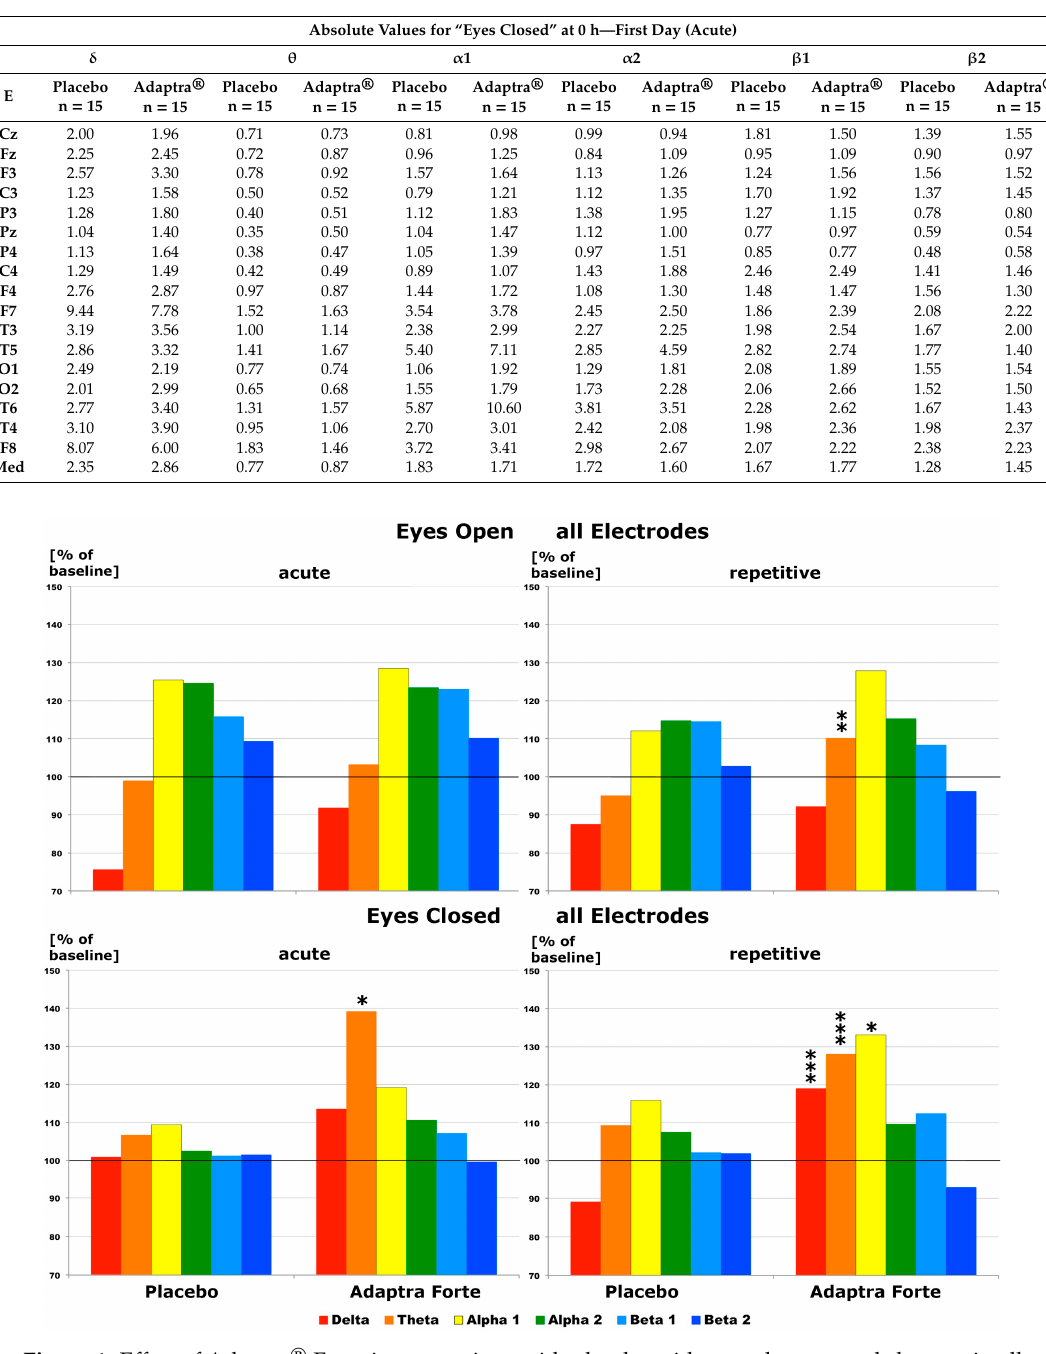
Figure 1. Effect of Adaptra ® Forte in comparison with placebo with regard to spectral changes in all brain regions and at all six frequency ranges (2 h after intake) regarding an average of all electrode positions during recording with either eyes open or eyes closed. Results from first experimental day (acute) on the left side, from the last day (repetitive) after 4 weeks of intake on the right side of the image. Baseline values were set as 100%. * p < 0.12; ** p < 0.05; *** p < 0.01. After setting spectral baseline values as 100%, drug-induced changes were documented for each electrode position and all frequencies at 2 h after intake of the trial drug. With respect to the placebo, we observed hardly any change during relaxation (eyes open recording condition), whereas with respect to Adaptra ® Forte, we observed statistically significant increases in spectral δ power in the parietal lobe on the first experimental day. In addition, at the parietal electrode position P 4 , we observed significant increases in spectral α and β power. In the temporal lobe, a conspicuous decrease of β 1 power was noted, whereas in the occipital lobe, we found a significant decrease in β 2 power (Figure 2). On the last experimental day after repetitive administration for four weeks, we again noted statistically significant δ power increases in central and parietal brain areas at only 2 h after intake of Adaptra ® Forte during relaxation. Statistically significant increases in spectral θ power were documented in five central, parietal, and temporal brain regions, as depicted in Figure 2. Statistically significantly increases in α 1 spectral power only occurred at electrode position C z .